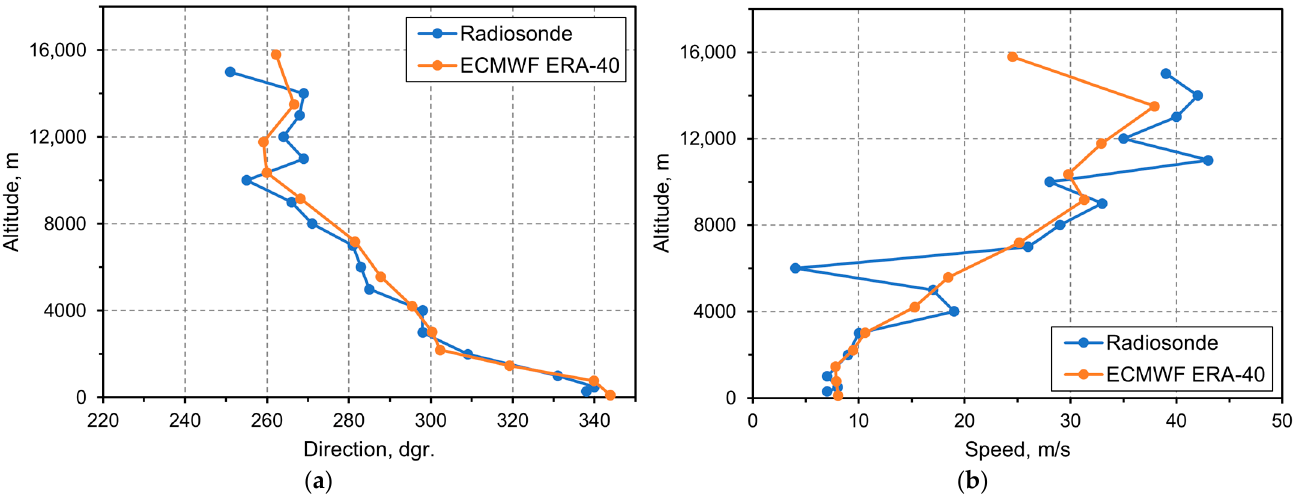
Figure 6. Wind characteristics according to the RSM00032618 station measurements (at 05:30 UTC on 12 November 1964) and to the ECMWF ERA-40 reanalysis results (at 06:00 UTC on 12 November 1964): ( a ) Direction; ( b ) Speed.